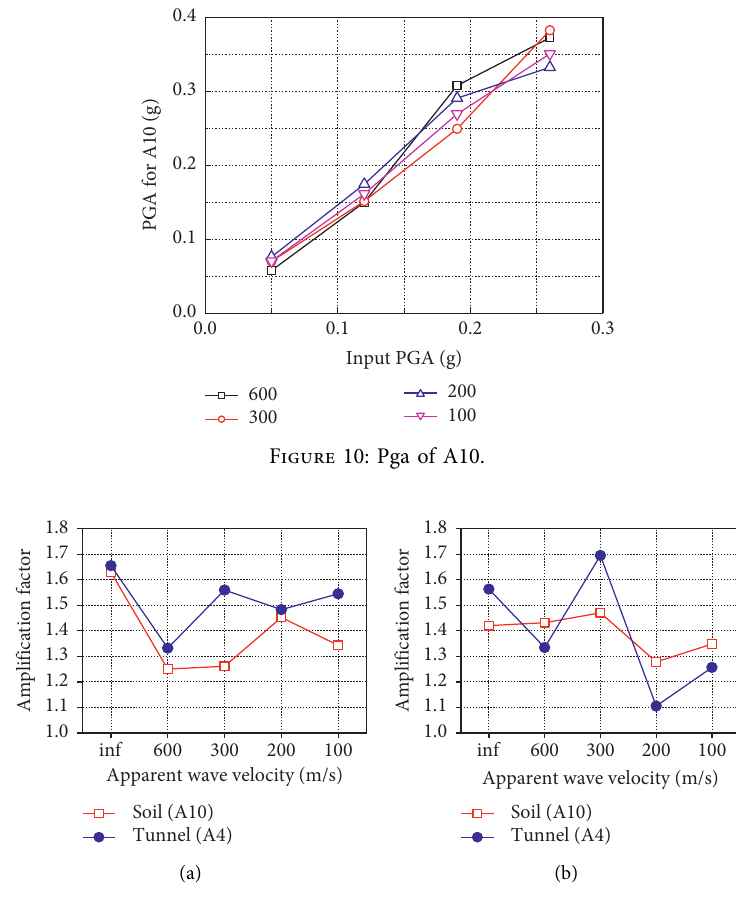
Figure 11: Acceleration amplification factor of soil and tunnel: (a) 0.12 g; (b)